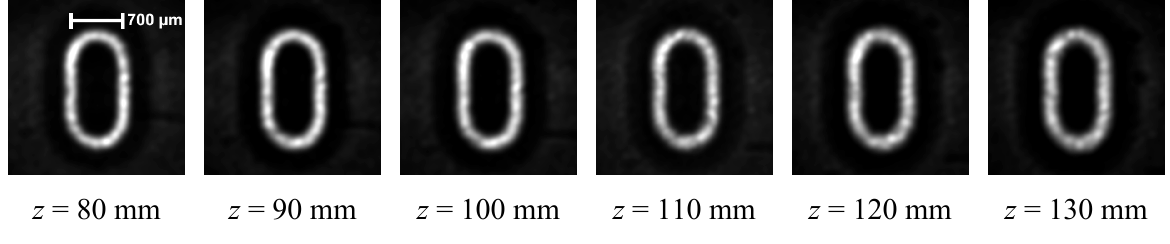
Figure 6. Nondiffracting intensity propagation of a stadium-shaped light bullet (time integrated, field of view 2.7 × 2.7 mm 2 , detected after SHG at 400 nm, initial pulse duration 6.5